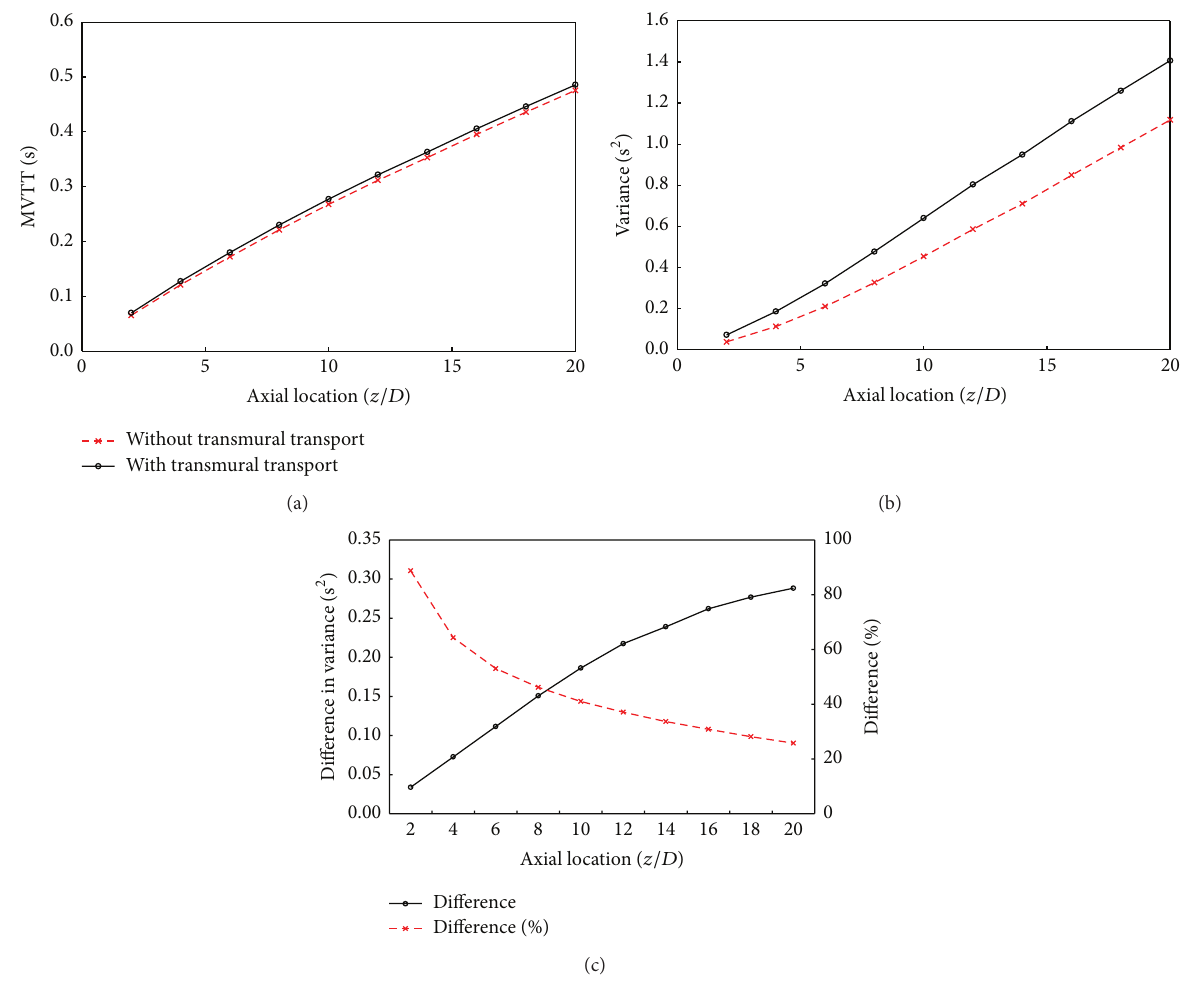
Figure 4: Comparison of the quantitative parameters of the bolus delay (MVTT) and dispersion (variance) in the unstenosed artery between the model with arterial transmural transport and without. (a) The mean vascular transit time (MVTT); (b) the variance of vascular transport function (variance); (c) the difference and percentage difference in